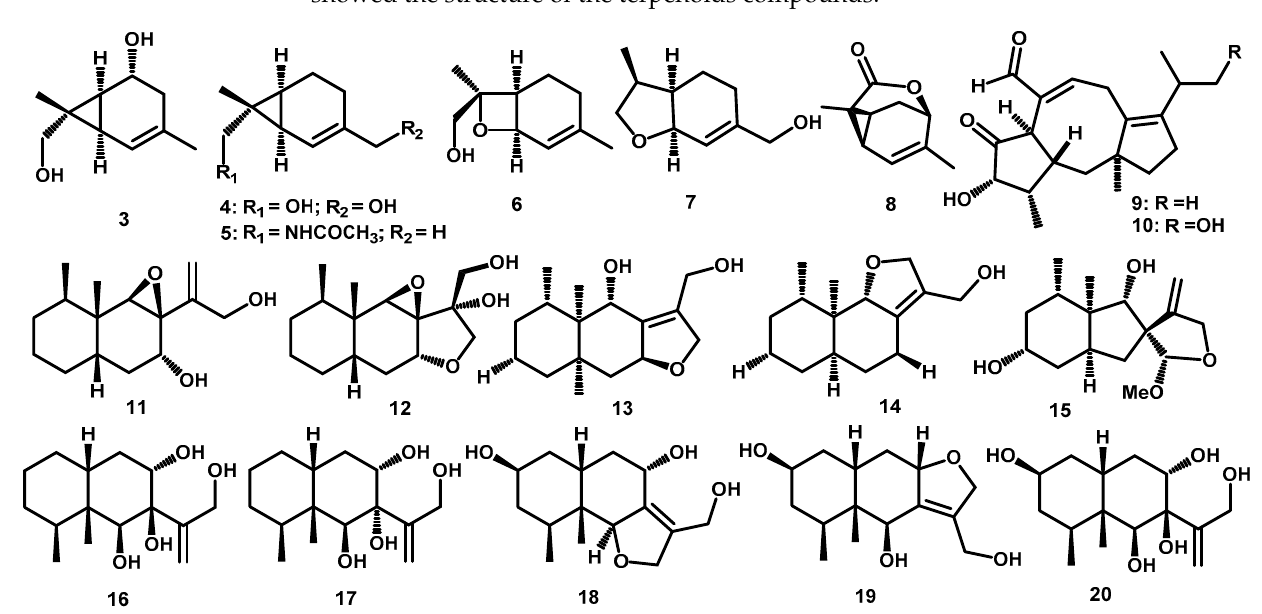
Figure 2. The chemical structures of terpenoids 3 – 20 from the Periconia genus.